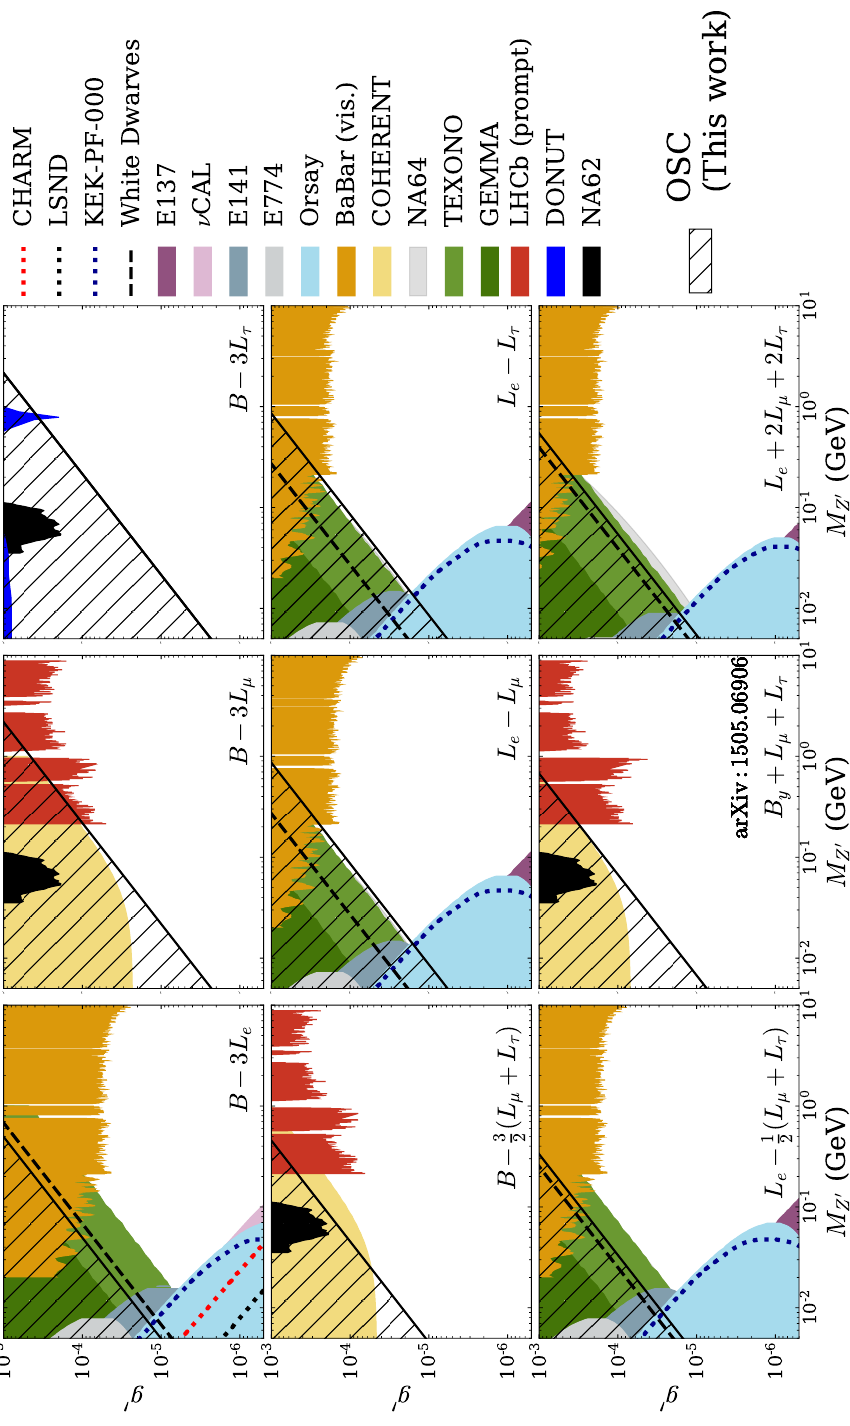
Figure 3. Values of g 0 and 5 MeV ≤ M Z 0 ≤ 10 GeV for which a U(1) 0 model coupled to the charges labeled in each panel gives a worse fit than standard oscillation by 2 σ , eq. (3.6) (hatched region).